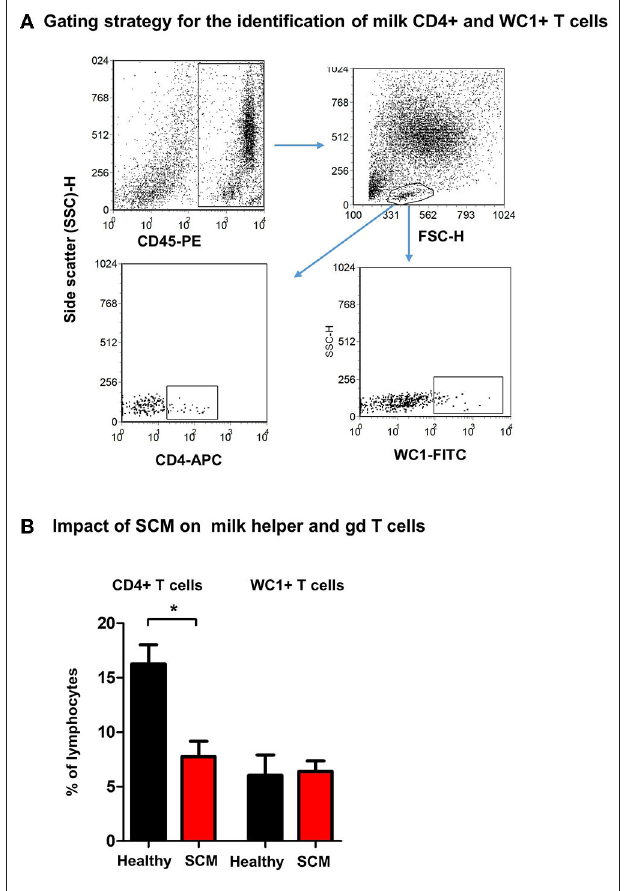
FIGURE 5 | Flow cytometric analysis of milk lymphocyte subsets. Separated milk cells were labeled with monoclonal antibodies to CD45, CD4, and WC1 and analyzed by flow cytometry. (A) After setting a gate on milk leukocytes in a CD45 against SSC-H dot plot, lymphocytes were identified based on their SSC and FSC properties. Milk helper T cells and gd T cells were identified within the lymphocyte population based on their staining with anti-CD4 and anti WC1 antibodies, respectively. (B) The percentage of T helper cells and gd T cells within the milk lymphocyte population were calculated for healthy and SCM camels and presented graphically. *indicates significant differences between the means with p -values < 0.05.